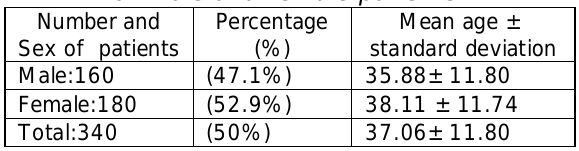
Table 1. Mean age and standard deviation of male and female patients: